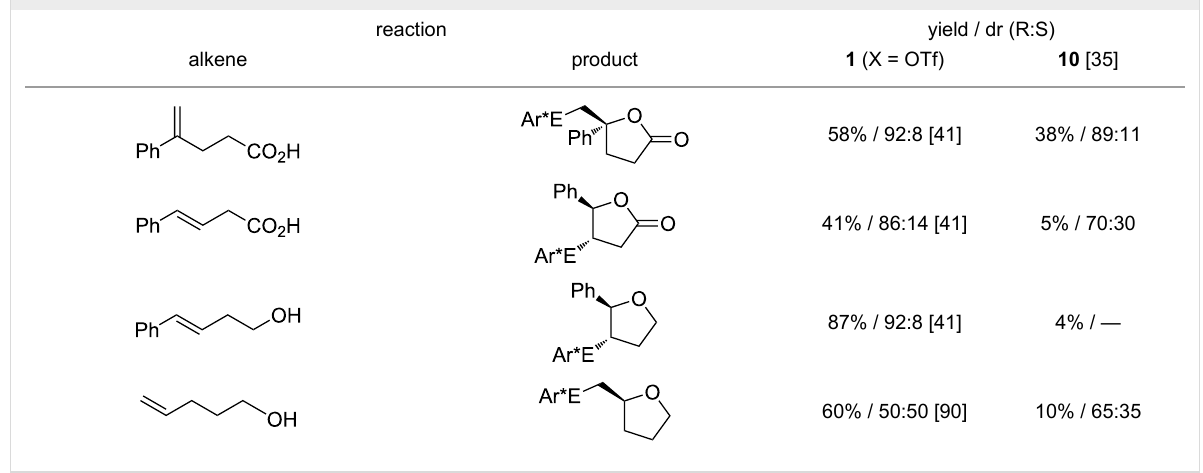
Table 7: Electrophilic cyclizations of alkenes with electrophiles 1 (X = OTf) and 10